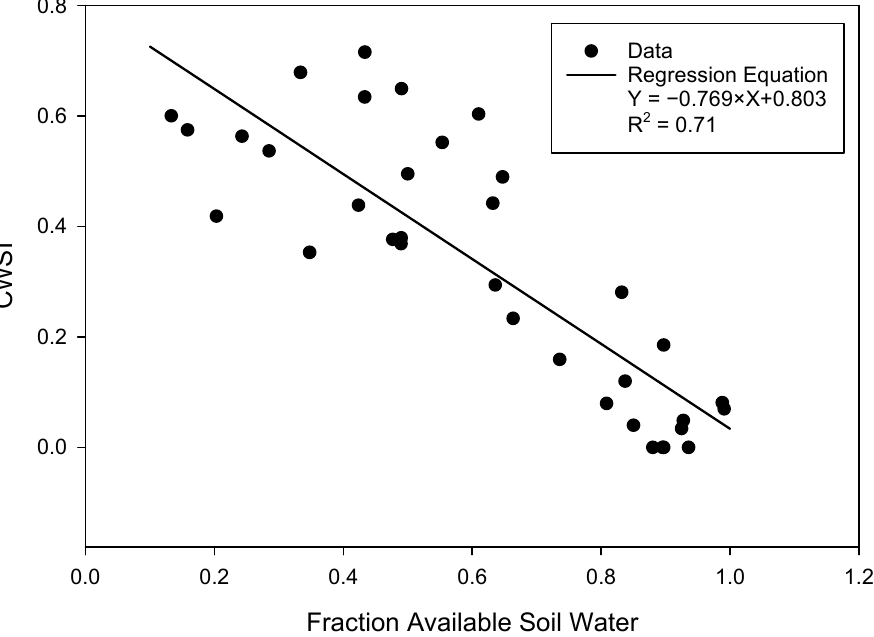
Figure 6. Relationship between the fraction of available soil water and crop water stress index ( CWSI ) in 2018.